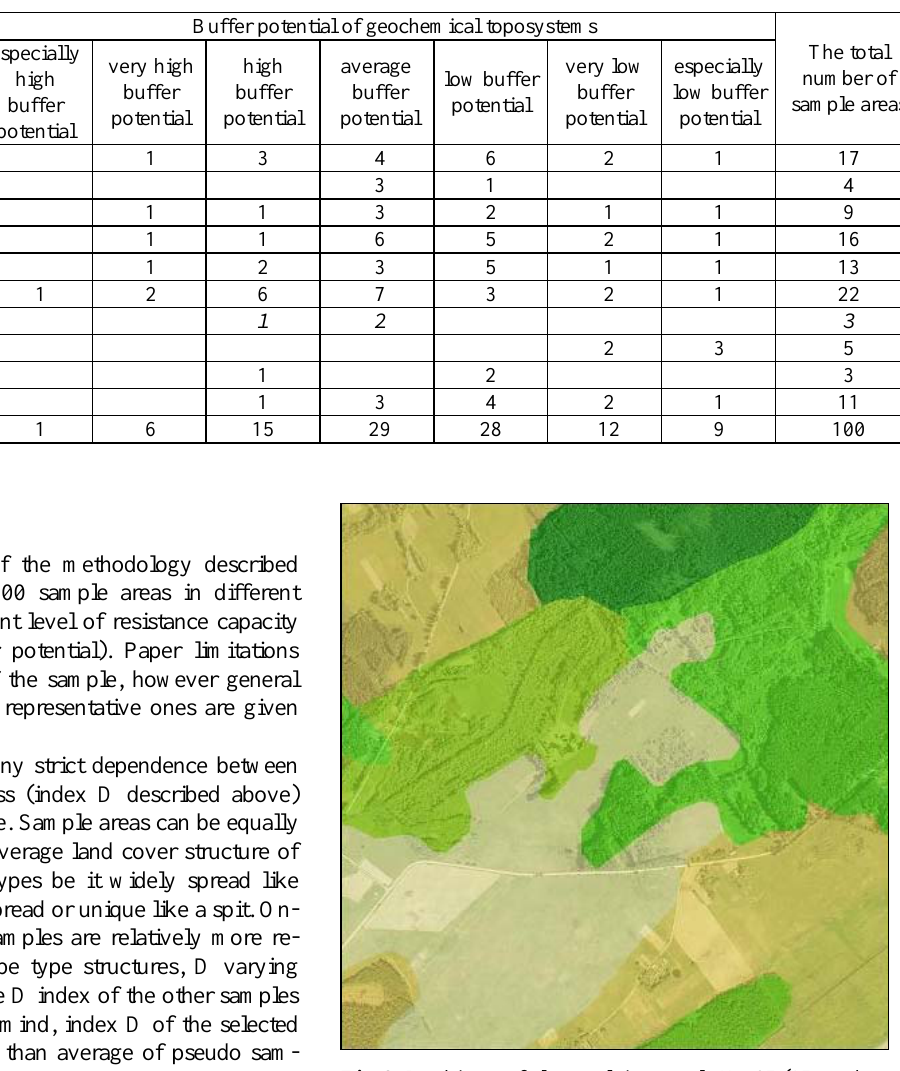
Fig. 3. Patchiness of clayey plain, sample No 65 (15 patches and 8 types of land cover, located in Rokiškis district). This sample represents a geosystem with low buffer potential * Figures 3 to 6 show patchiness of samples calculated using rather small scale cartographic data (CORINE which is in scale of 1:100 000) and can give only general infor- mation useful for selecting sample locations. For landscape monitoring purposes, however, real patchiness should be evaluated and at much larger scale, like that in orthophoto images depicted bellow the colour cartoschemes of the mentioned figures. Mapping, vectorising and analysis of the large scale cartographic data in different historical pe- riods are the other steps in landscape monitoring. After all mentioned procedures, 100 sample areas scattered in different types of landscape of varying sensi- bility were distinguished (Fig.